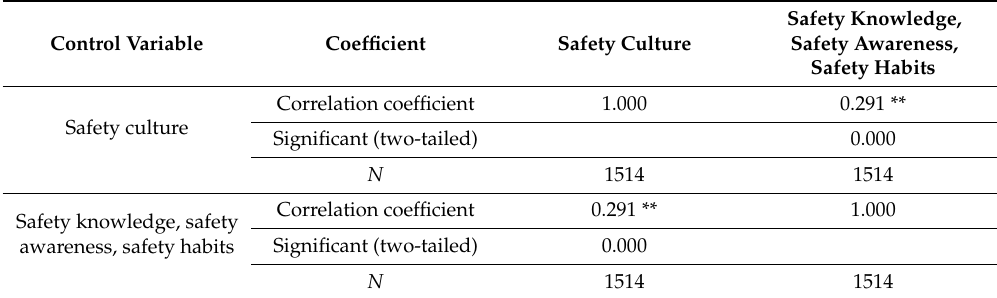
Table 5. Correlation coefficient between safety culture and safety knowledge, safety awareness and safety